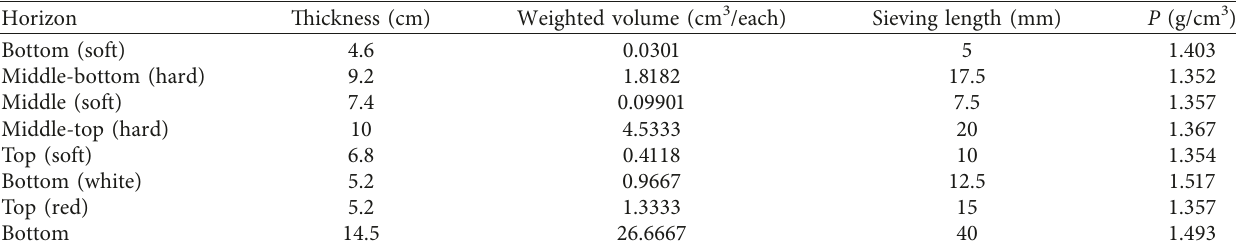
Table 7: Parameters of top coal and direct